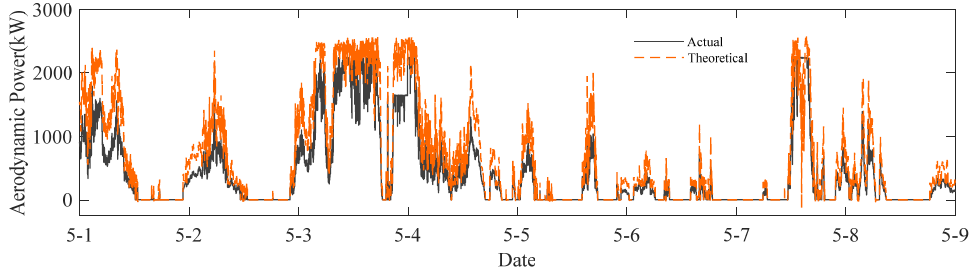
Figure 3. Comparison of theoretical aerodynamic power and historical aerodynamic power.